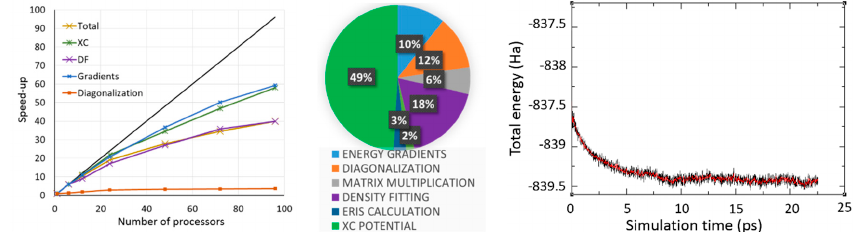
Figure 3. Computational performances for QM/MM Born–Oppenheimer molecular dynamics (BOMD) simulation. Left: speed-up as a function of number of processors. Only tasks representing more than 15% of total execution time are depicted. Middle: pie chart illustrating the most computationally demanding task (taking the job run on 48 processors). Right: energy conservation for in the microcanonical simulations.